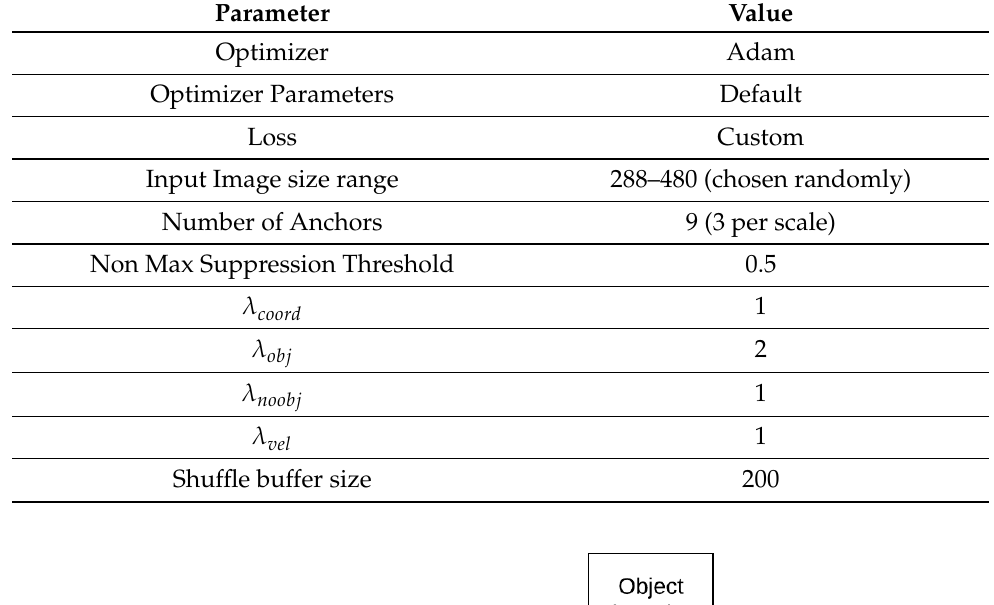
Table 6. YOLO network hyper-parameters.